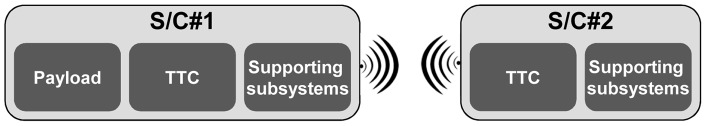
Example of a space-based network.